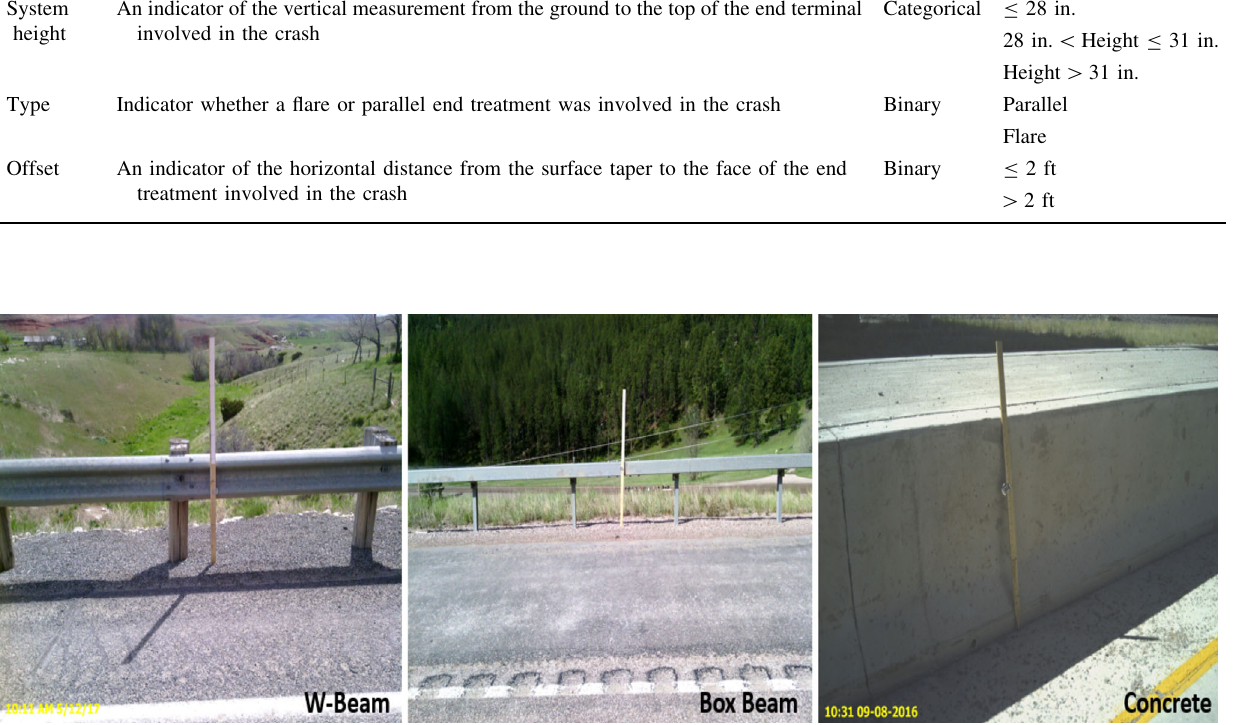
Fig. 2 Traffic barrier types considered in the